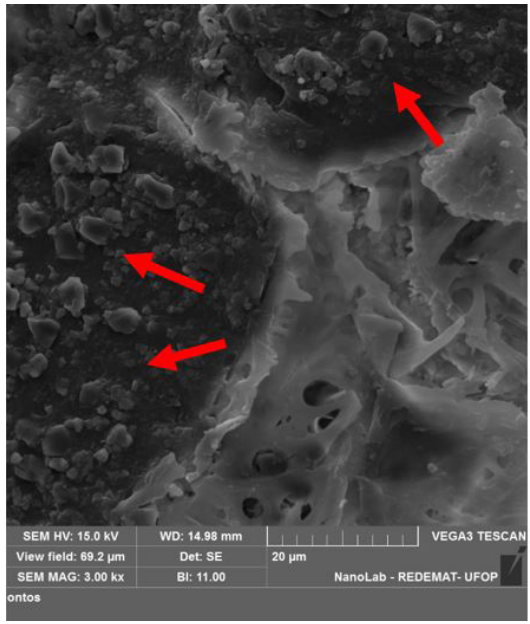
Figure 9. Micrograph of sampleAF75-01 tested at 28 days with 3000x